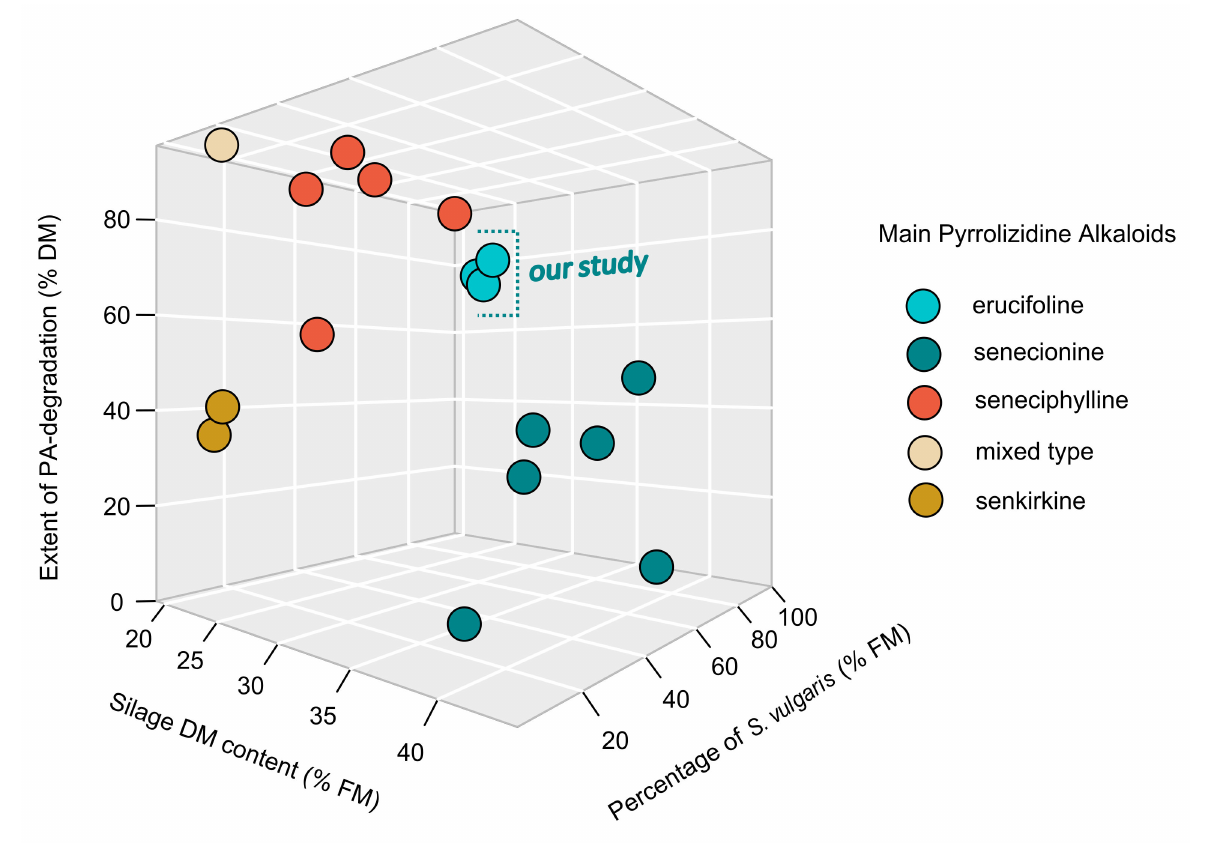
Figure 3. Extent of PA/PANO-degradation during ensiling of our study and comparable studies with PA-containing Senecio species. Results are ordinated according to the dry matter content of their silage substrates and the percentage of the S. vulgaris resp. Senecio biomass in the ensiled feedstock. The main types of the pyrrolizidine alkaloids are color coded (see legend for